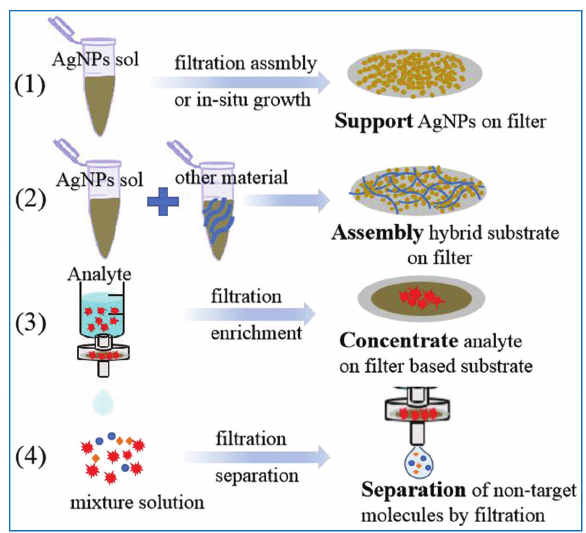
Scheme 2: Schematic the functions of filter-based substrates introduced in Section